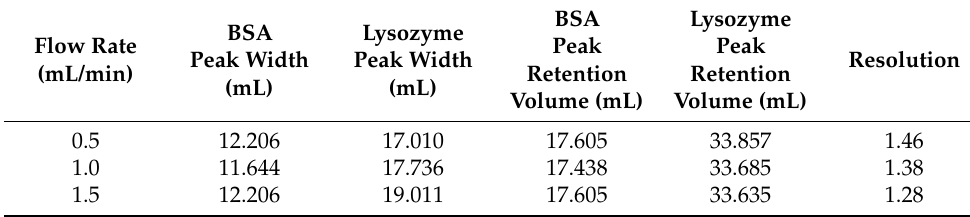
Figure 8. Chromatograms obtained during BSA (5 mg/mL) and lysozyme (2.5 mg/mL) separation using 24 mL z 2 cuboid SEC device by loading 7.5 mL of feed sample at different flow rates: ( A ) 0.5 mL/min, ( B ) 1 mL/min, ( C ) 1.5 mL/min (medium: Sephacryl S-200 HR; mobile phase: phosphate-buffered saline (pH 7.4)). Table 4. Resolution in BSA–lysozyme separation using Sephacryl S-200 HR medium in 24 mL z 2 cuboid packed-bed device (mobile phase: phosphate-buffered saline, pH 7.4; loop: 7.5 mL; feed: 5 mg/mL BSA + 2.5 mg/mL lysozyme).